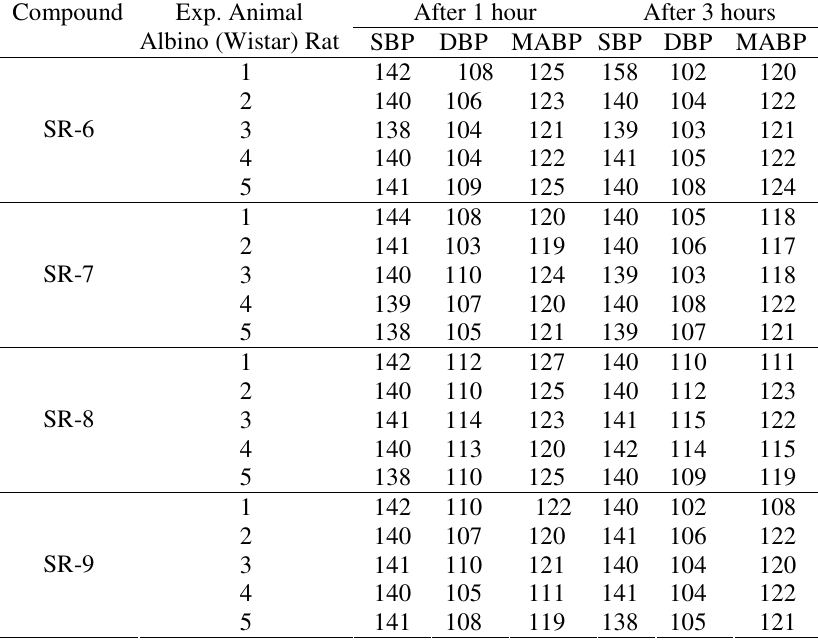
Table 1. Hypertension induced in normotensive rat